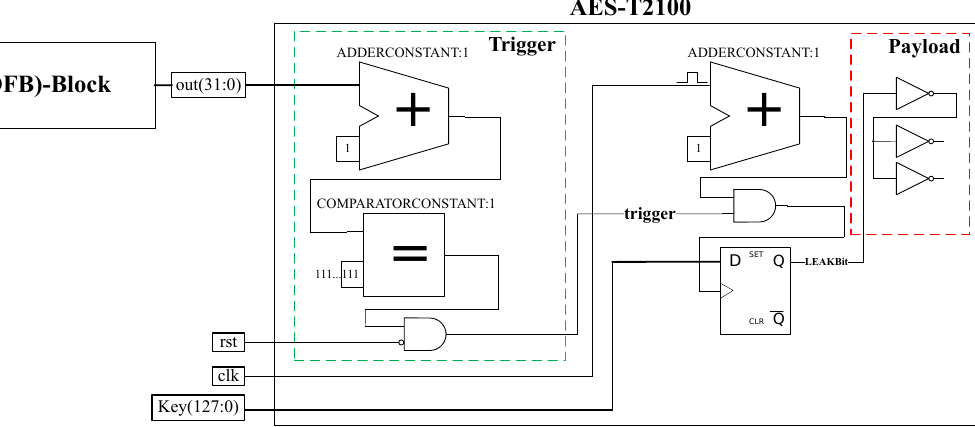
Figure 5. Circuit diagram of AES-T2100 Trojan.